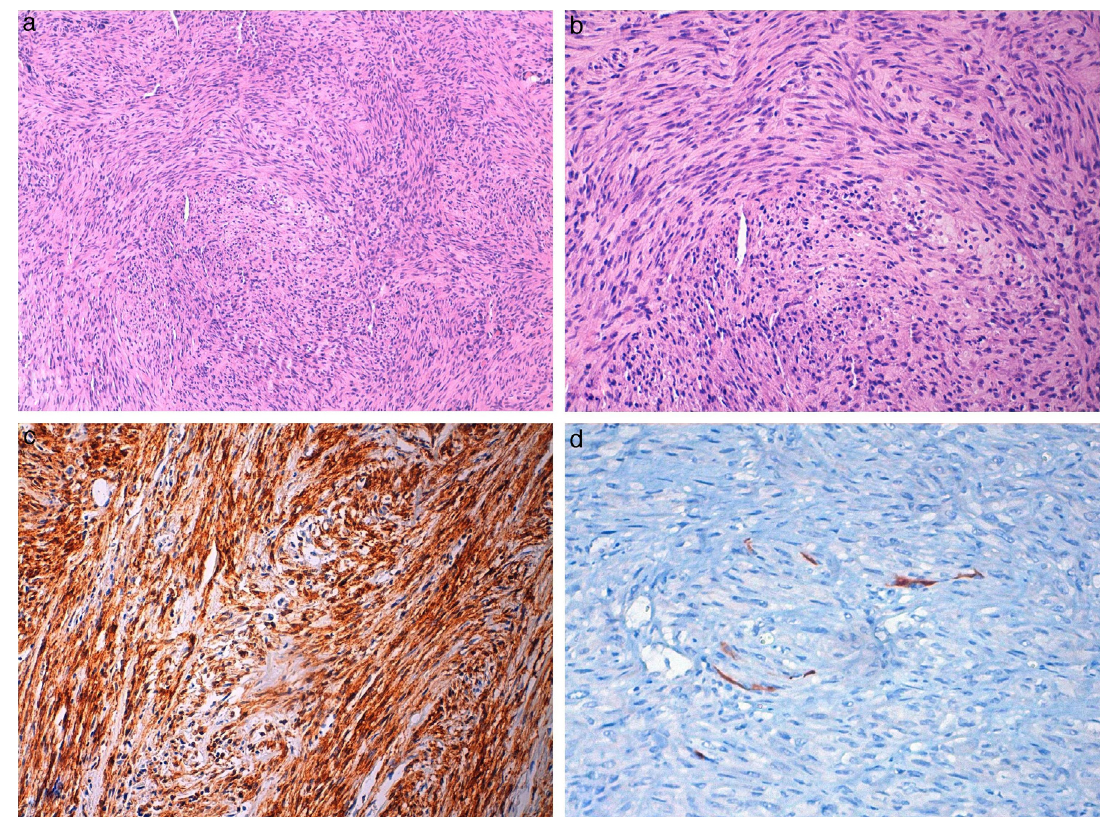
Figure 5 (a, b) Photomicrograph of Case 2, showing spindle cell tumor similar to Case 1 (hematoxylin and eosin × 100, × 200). (c) Tumor cells showing diffuse actin positivity ( × 200) and (d) focal desmin positivity ( × 400).